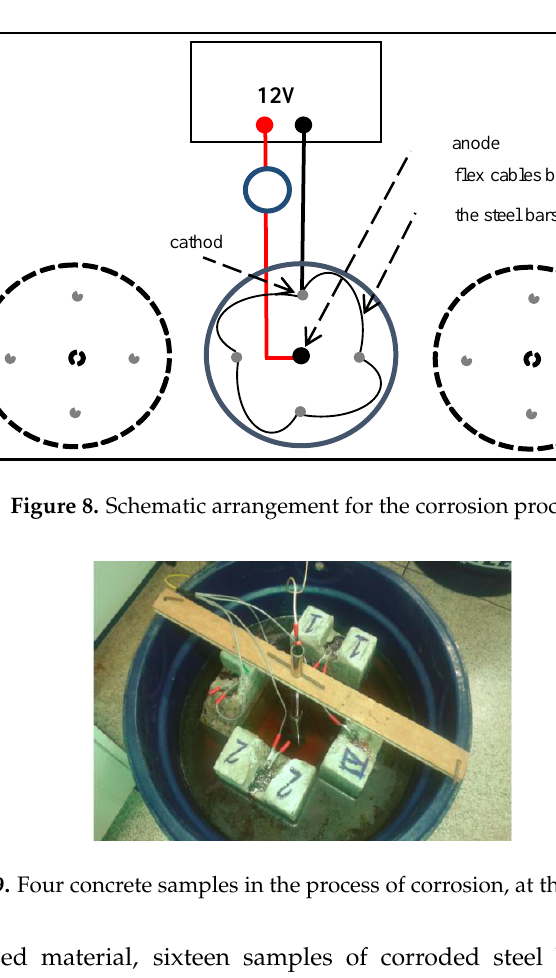
( d ) Figure 7. Simulated (color marks) and experimental results (hollow black marks) for the effective resistance ( a ), effective inductance ( b ), voltage ( c ) and phase angle ( d ) for a 20 mm steel bar. Red marks: Steel bar placed 25 mm under the sensor. Blue marks: Steel bar placed 45 mm under the sensor. 4. The Production of Corroded Samples of Steel Bars The corrosion process of the reinforcement of concrete structures is, in general, quite slow. Corrosion acceleration techniques are an important part of the studies on this subject. The impressed